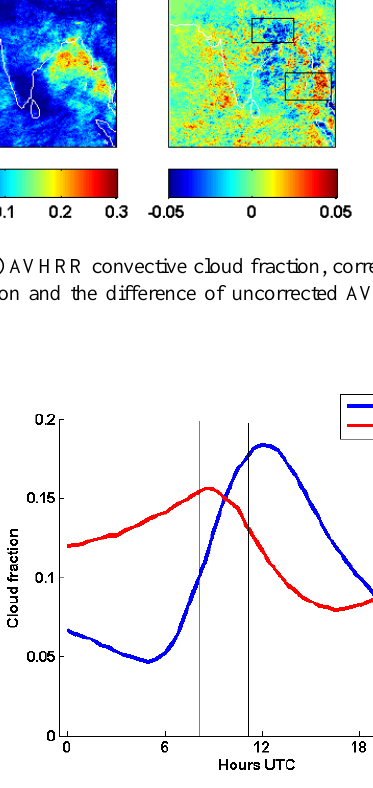
Fig. 10: Diurnal cycle of convective cloud fraction (BT<220 K) for JJAS 2006 derived Fig. 10. Diurnal cycle of convective cloud fraction (BT < 220K) using MVIRI-METEOSAT over two areas marked by rectangles in the rightmost panel in for JJAS 2006 derived using MVIRI-METEOSAT over two areas Fig. 9. The two vertical lines at 08:00 and 11:00 UTC denote the approximate times marked by rectangles in the rightmost panel in Fig. 9. The two within which the satellites are drifted over the study area. vertical lines at 08:00 and 11:00UTC denote the approximate times within which the satellites are drifted over the study